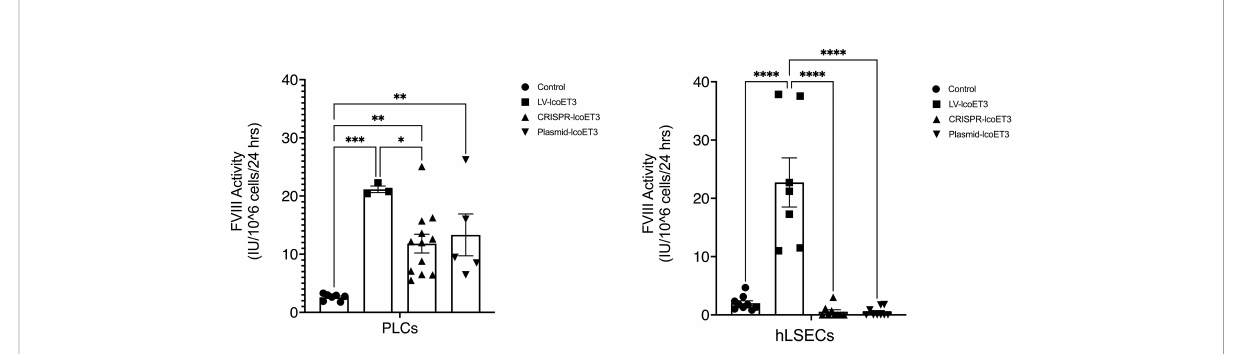
FIGURE 5 Evaluation of FVIII coagulation activity by activated partial thromboplastin time (aPTT) assay performed on 24h culture supernatants after normalization for cell number in each sample. Data are presented as the amount of functional FVIII in International Units (IU) being produced by 10 6 cells in 24h. ( A – PLCs, B – hLSECs). n = 7 for unmodi fi ed/control PLCs, n = 3 for LV-lcoET3 PLCs, n = 12 for CRISPR-edited PLCs, and n = 5 for Plasmid-lcoET3-transfected PLCs; n = 7-9 for all hLSEC groups. *p<0.05; **p<0.01; ***p<0.001;